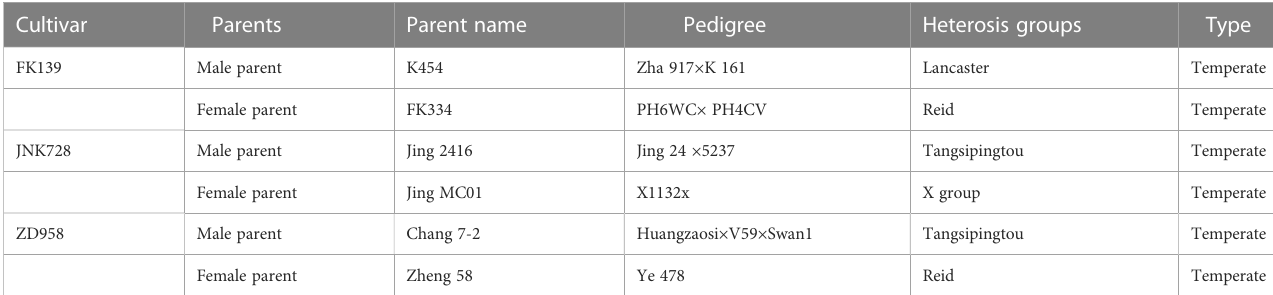
TABLE 1 The sources of maize cultivars selected for study from 2018 – 2020.